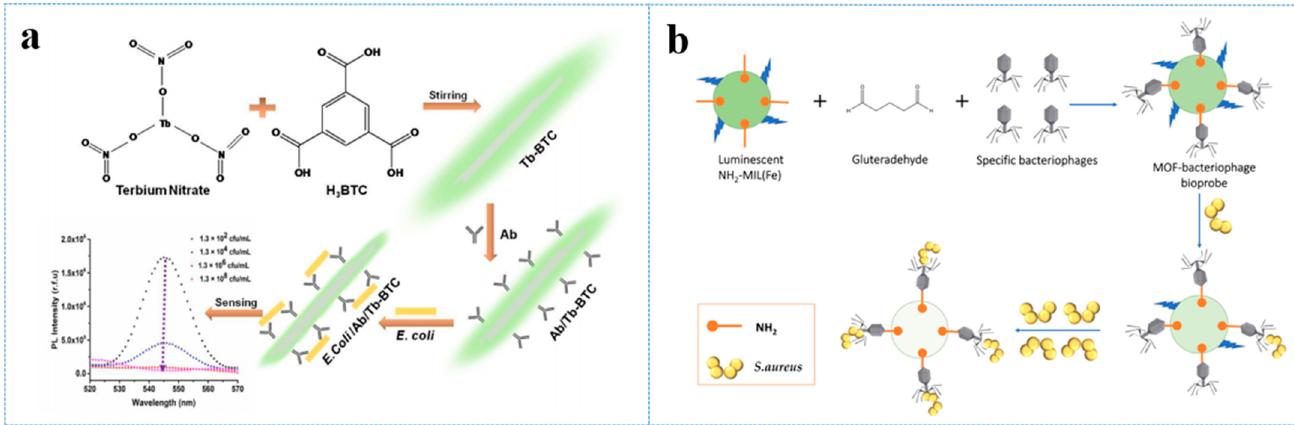
Figure 6. ( a ) Schematic diagram for the application of Ab/Tb-BTC for detecting E. coli , reprinted with modifications from Gupta et al. [123]; ( b ) schematic diagram for the application of NH 2 -MIL-53 (Fe) for sensing S. aureus , adapted from Bhardwaj et al. [124].